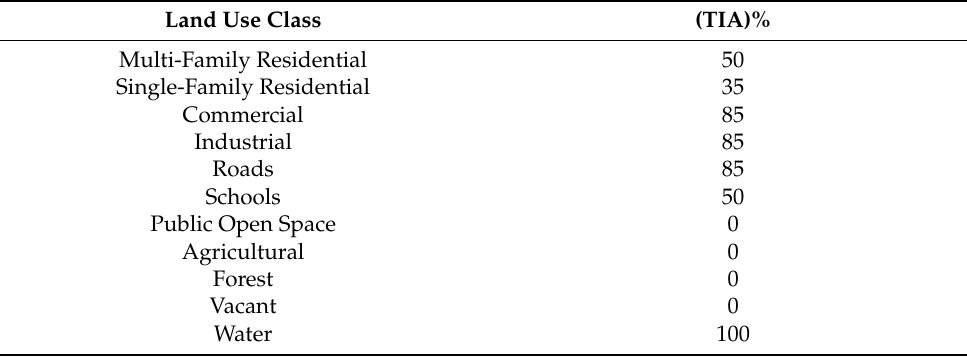
Table 2. Examples of TIA percentages used in this